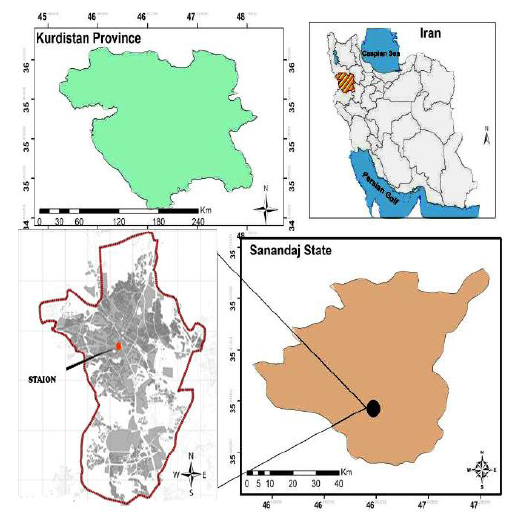
Figure 1. Location of monitoring site, Sanandaj (35°18′52″N, Remove the confounding variables